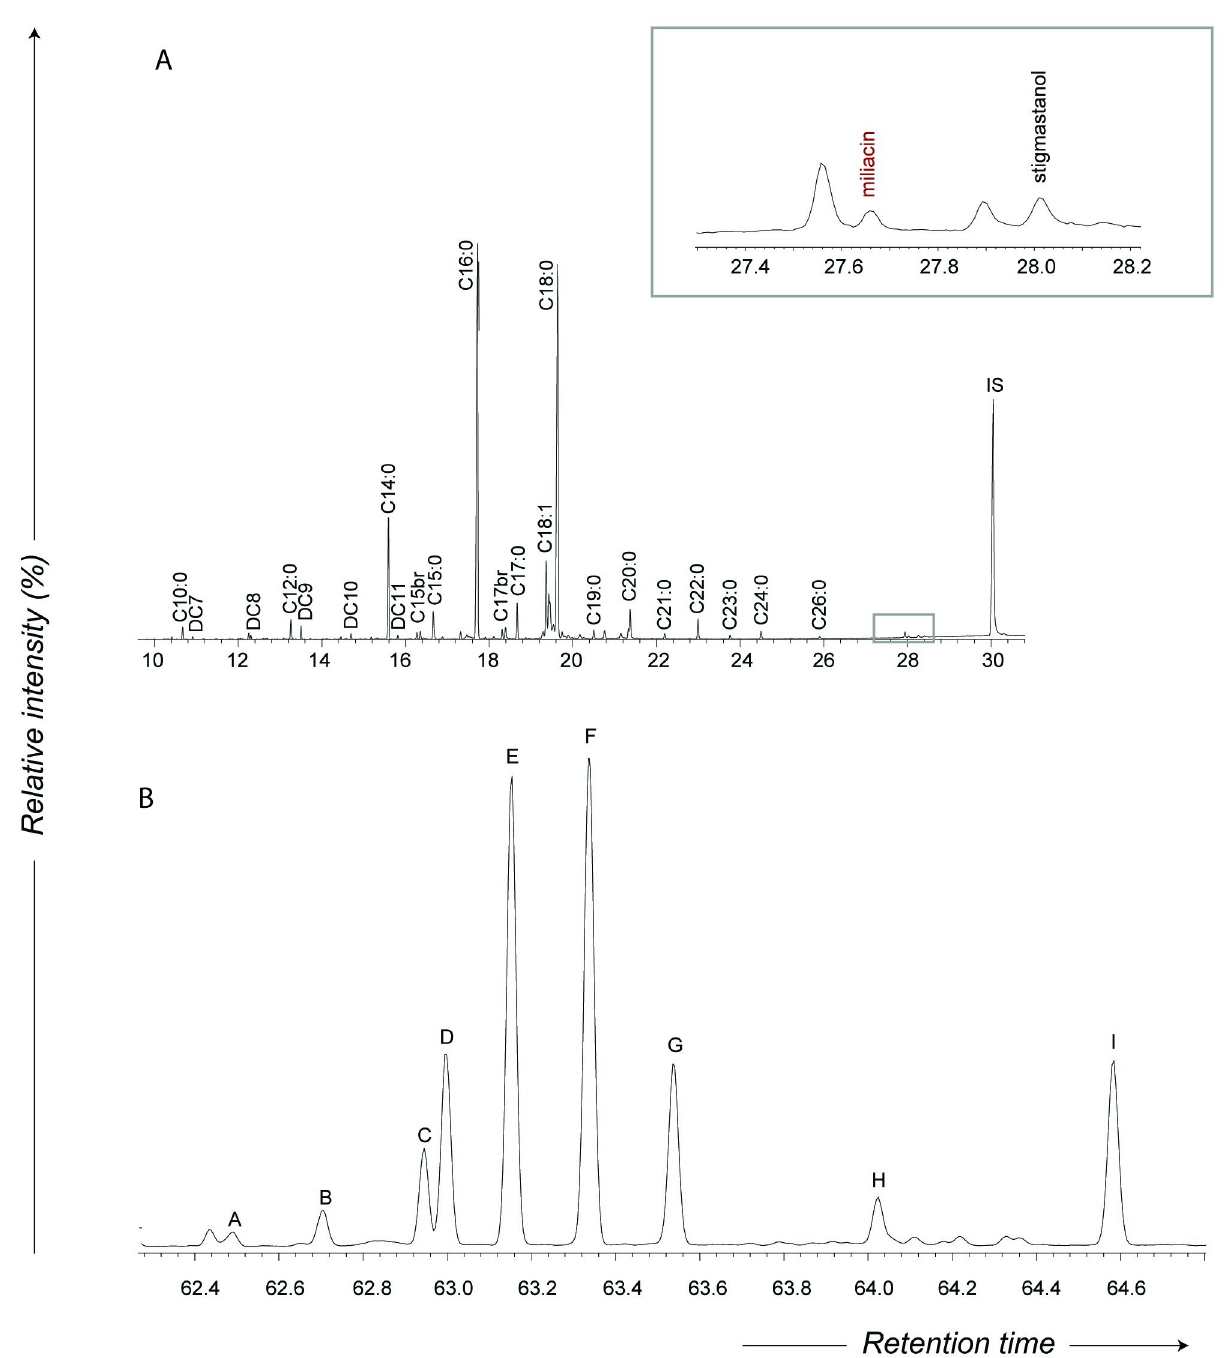
Fig 10. Partial gas chromatograms of lipid extract M51-1-F obtained by direct acid-catalyzed transesterification (for more details see S1 File). A. Partial chromatogram obtained with a DB5-ms (5%-phenyl)-methyl polysiloxane column: Cn:x are fatty acids with carbon length n and number of unsaturations x; br are branched-chain acids; IS are the internal standards (n-tetratriacontane and n-hexatriacontane). The insert shows peaks corresponding to miliacin (olean-18-en-3 β -ol methyl ether), a plant biomarker enriched in grains of broomcorn millet (Panicum miliaceum) and stigmastanol, another plant biomarker identified. To monitor the retention time and confirm the presence of miliacin, an authentic standard of miliacin was injected in the same GCMS run. B. Partial SIM chromatogram (m/z 105 ion) obtained with a DB23 (50%-Cyanopropyl)-methylpolysiloxane column shows the distribution of ω -(o-alkylphenyl)alkanoic acids with 18 carbon atoms (letters from A to I corresponding to the isomers).